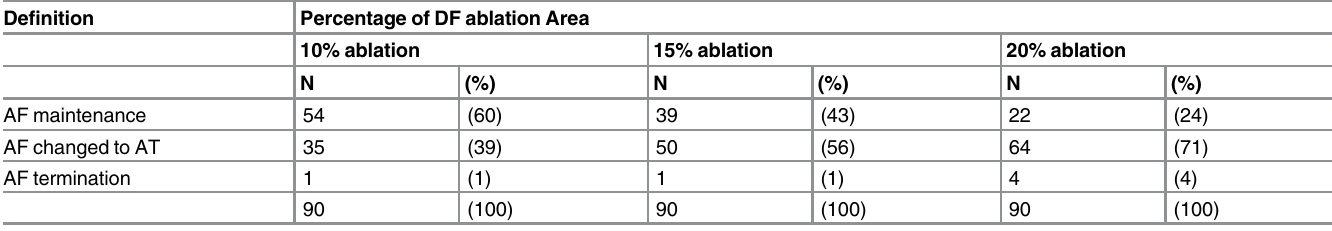
Table 2. Outcome of Virtual Ablation for High DF Area depending on Extent of Ablation